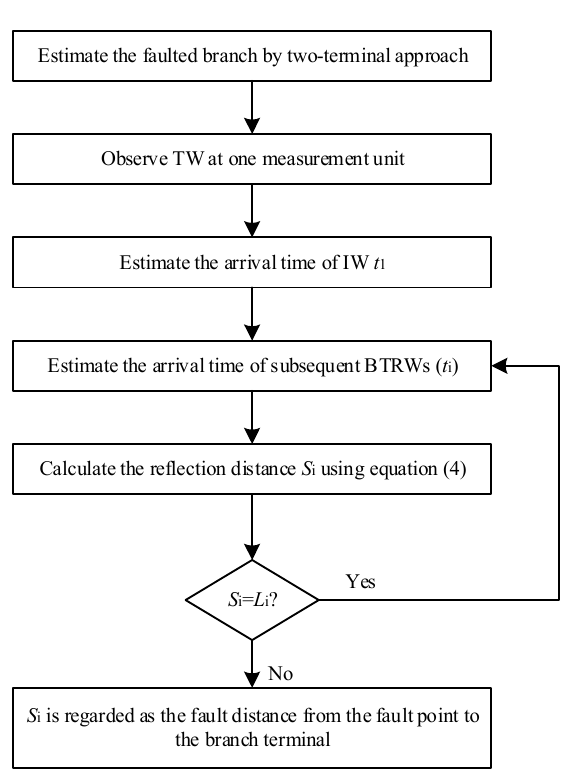
Figure 4. Fault location on a branch.